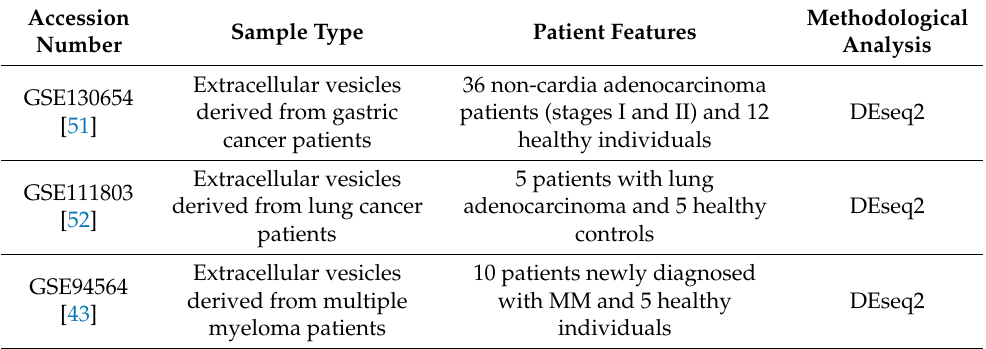
Table 4. Summary of miRNA datasets among different cancer types for this study.